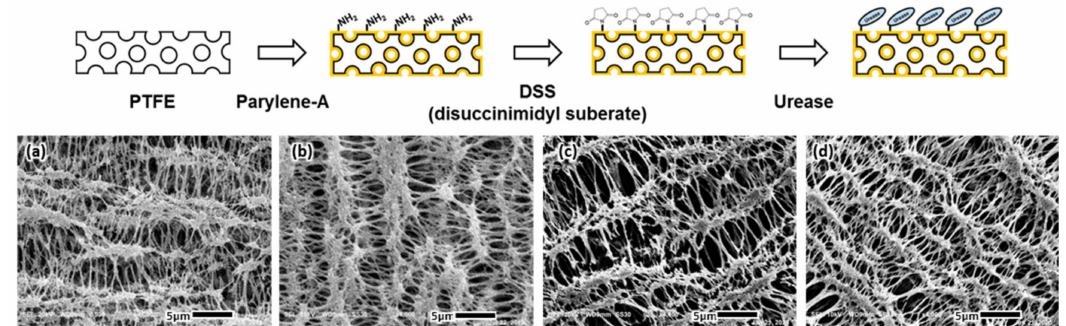
Figure 3. The microstructure of the PTFE membrane during the urease immobilization process, namely the ( a ) bare, ( b ) parylene-A coated, ( c ) DSS treated, and ( d ) urease-immobilized PTFE